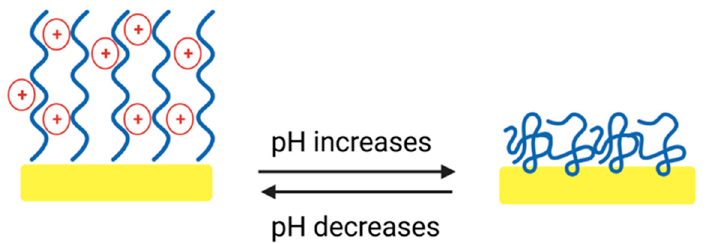
Figure 7. Schematic representation of the plasma-polymerized (p(HEMA-co-DEAEMA) films at dif- ferent pHs. Created with BioRender.com.